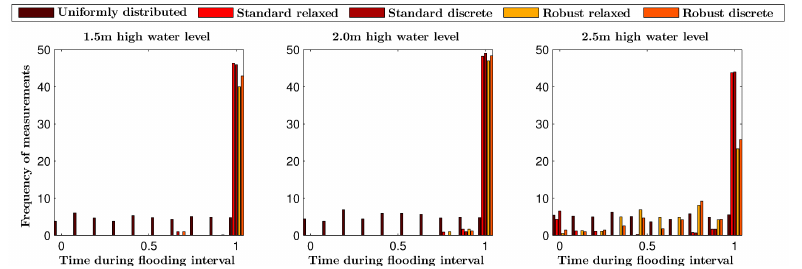
Figure 6. Averaged frequency of measurements from 10 optimization runs with the C 3 -model and three measurement per iteration with standard deviation 10 − 2 of the measurement